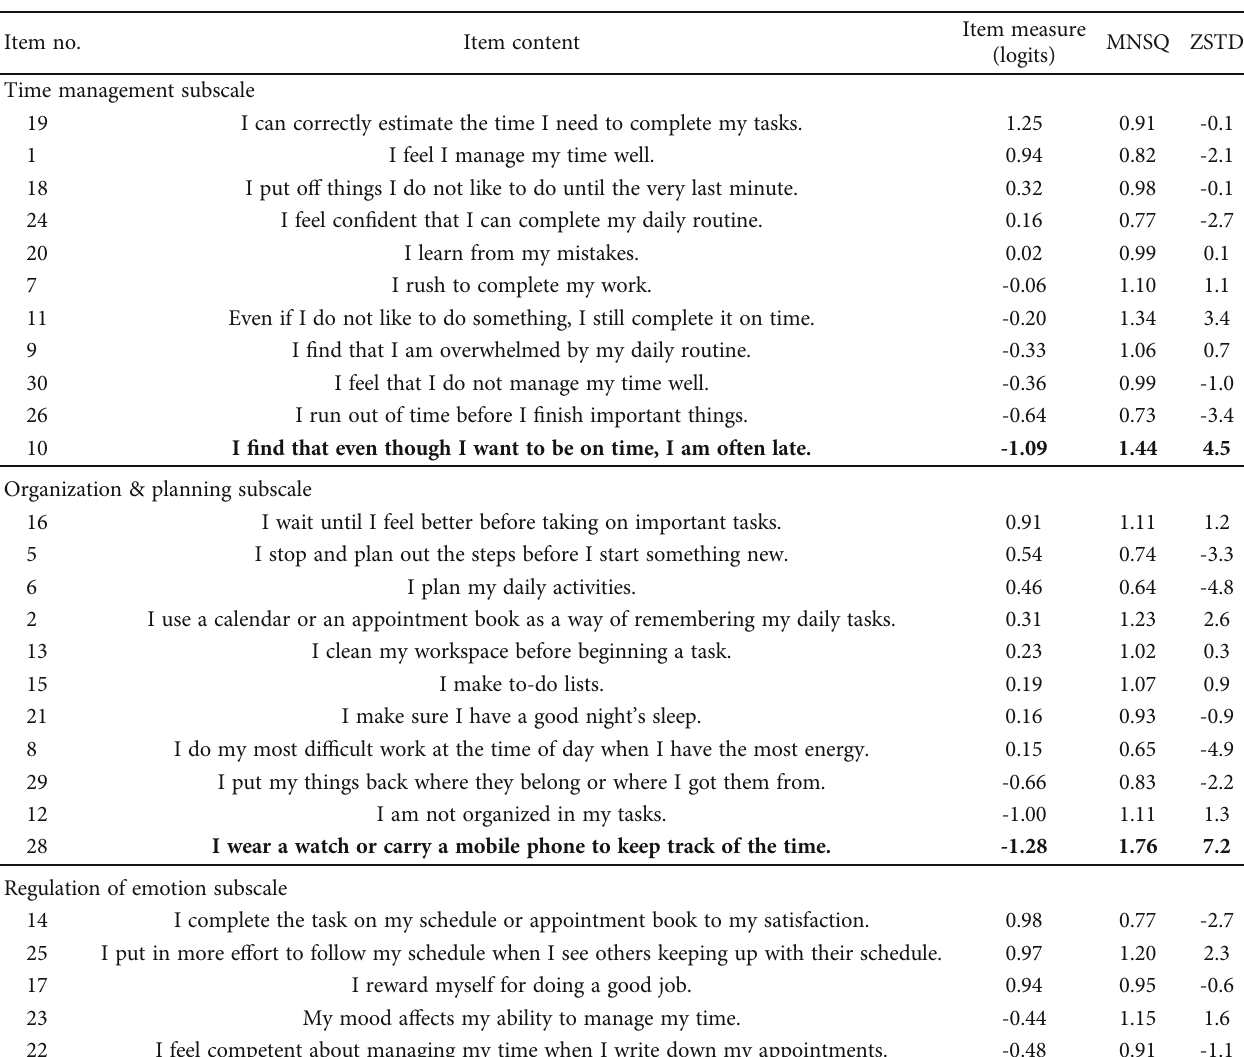
Table 2: Items in each of the three subscales, listed in item di ffi culty order and with item fi t statistics. Item